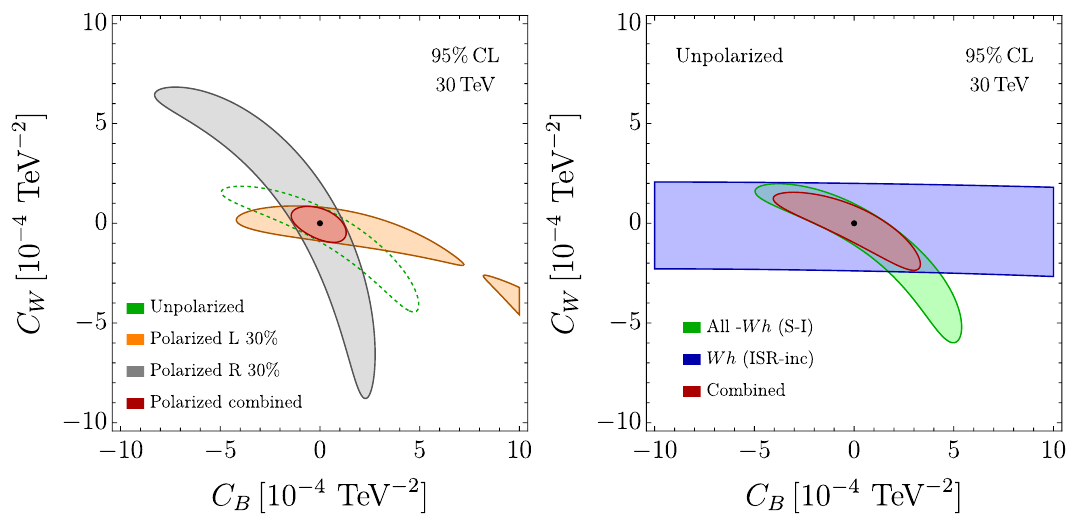
Figure 9. Left Panel: 95% CL contours in for P L = ± 30% beam polarization. Right Panel: the impact of the ISR-inclusive Wh cross-section